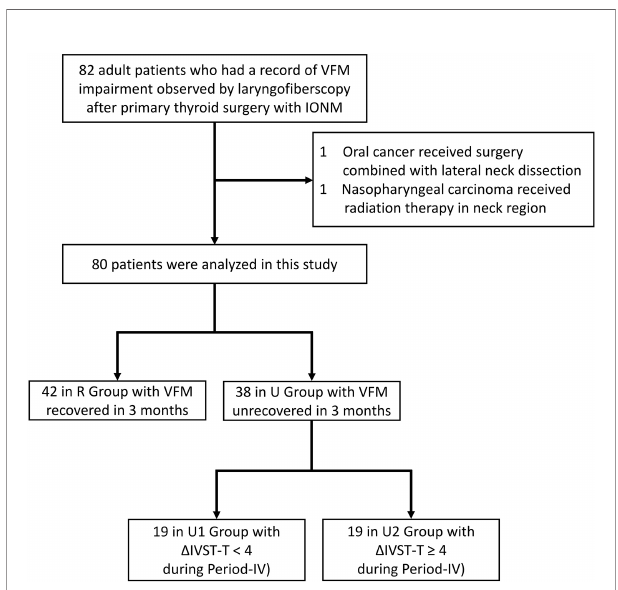
FIGURE 1 | Flow diagram for inclusion and exclusion of patients. VFM, vocal fold motion; IONM, intraoperative neuromonitoring; IVST, Index of Voice and Swallowing Handicap of